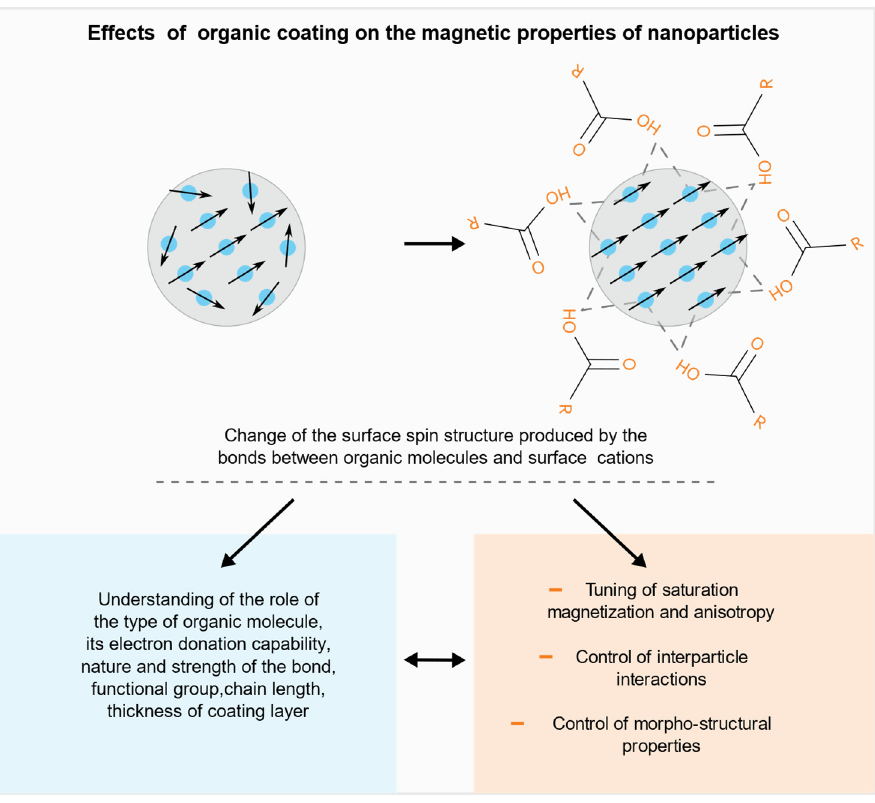
Figure 1. Schematic diagram showing the effect of the organic coating on the surface spin structure. The nanoparticles can be functionalized by a post synthesis process allowing to finely tune the magnetic properties of the single particle. The main effects of the reduction of the surface disorder produced by the organic coating on the magnetic properties